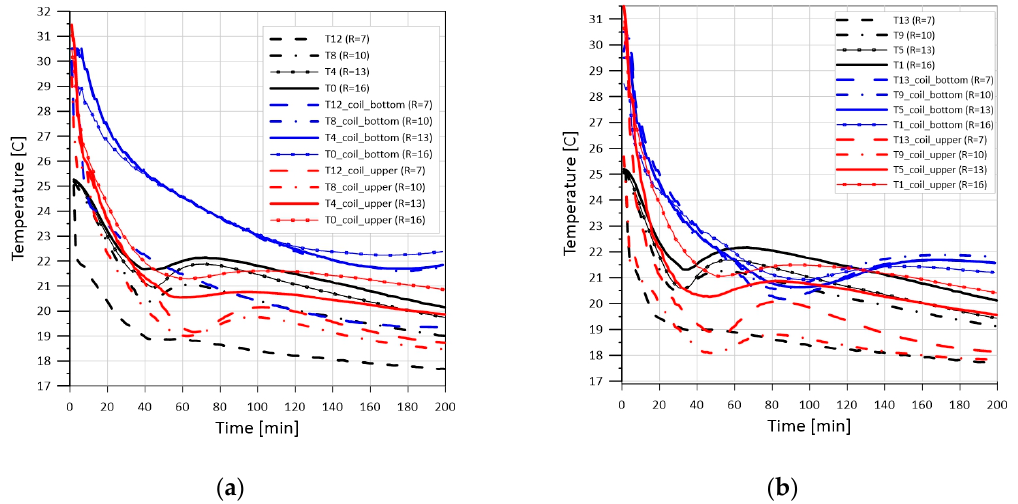
Figure 7. Temperature profile evolution as a function of the radial position during the solidification process with constant wall temperature condition ( Ts = 17 °C) on surface S1 ( a ) and S2 ( b ).